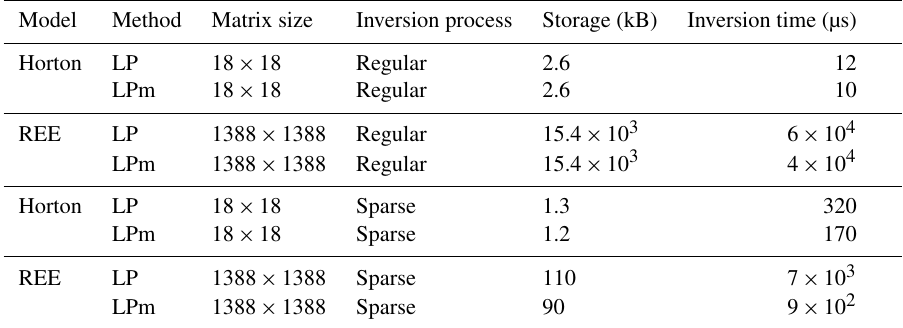
Table 8. Properties of the matrices to be inverted using the LP and LPm methods for different power networks, namely the Horton et al. (2012) benchmark and REE. Model Method Matrix size Inversion process Storage (kB) Inversion time